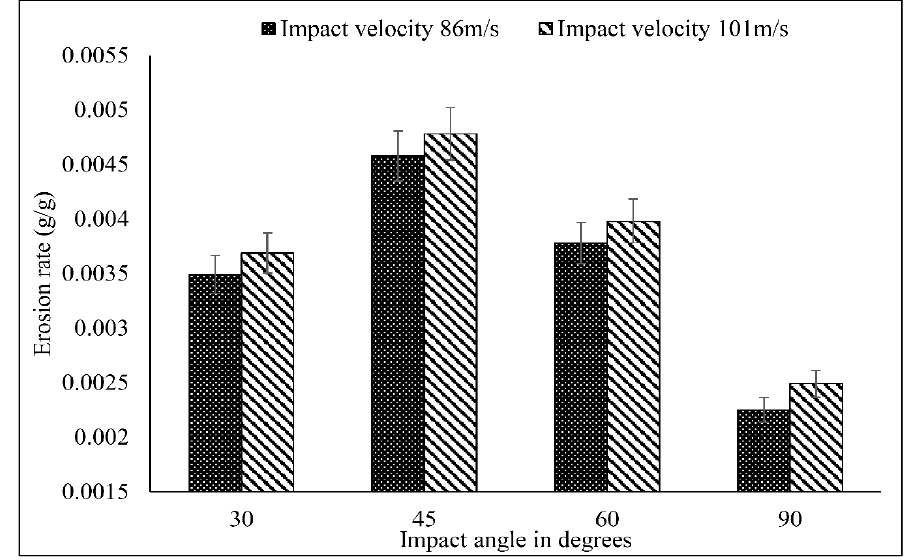
Figure 7. Erosion rate for 3wt% of filler nanocomposites at an impact velocity of 86m/s and